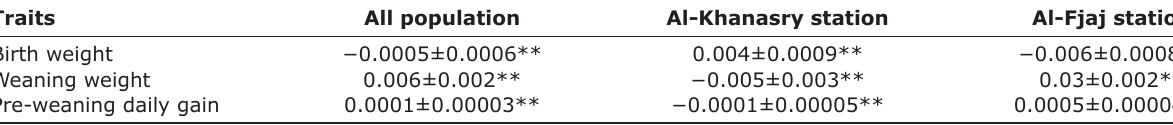
Table-5: Genetic trend for pre-weaning growth traits in Awassi lambs. Traits All